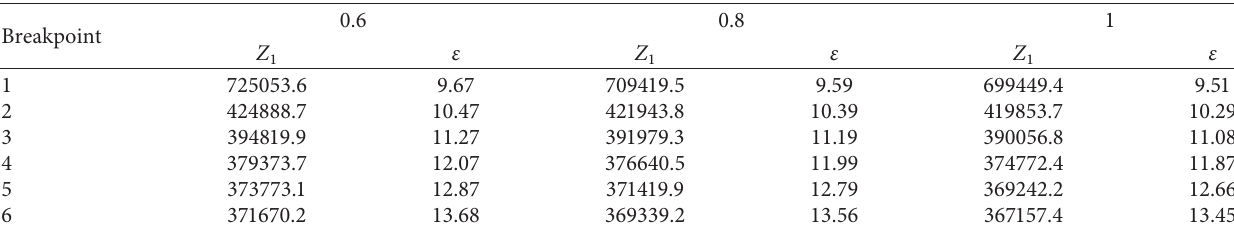
Table 8: The value of the cost objective function for breakpoints of the first sample problem.